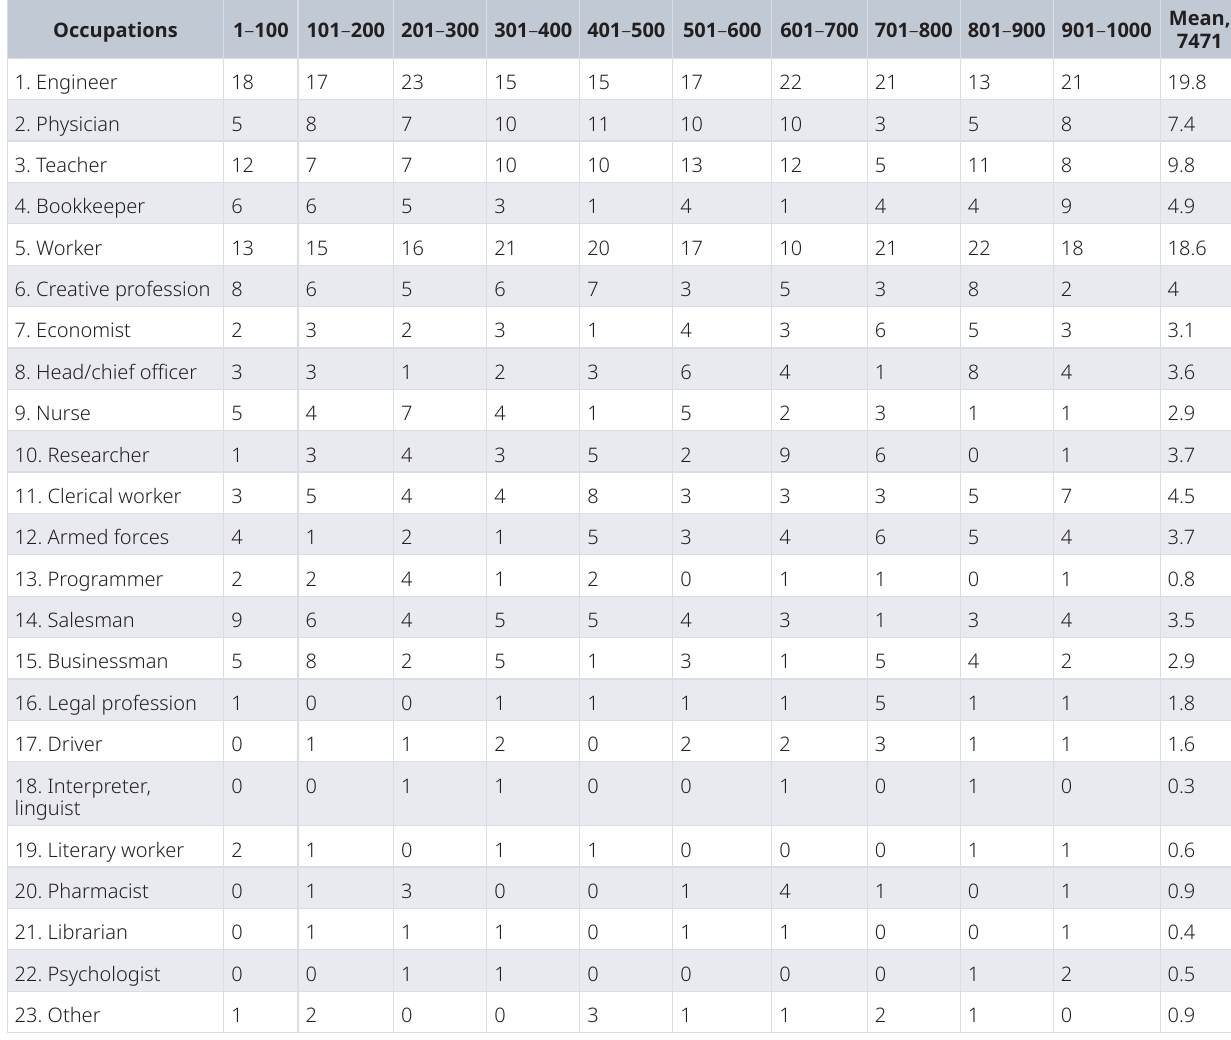
Table 2. Results of counting the number of individuals with different professions by hundreds for the pool of 7471 bearers of generic surnames. The first column provides the profession. The entries of the first row provide the considered range of numbers of people in the list considered in the corresponding column. For instance, the second column describes occupational distribution of 100 individuals with numbers from 1 to 100, the third column describes 100 individuals with numbers from 101 to 200 and so forth. Thus X (300) is the number of individuals with the profession of economist in the range from 201 to 300. This number is located at the 7 intersection of eighth row and fourth column,